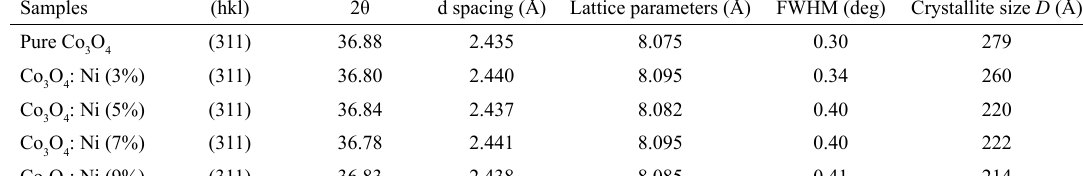
Table 3. Structural parameters of pure and Ni-doped Co